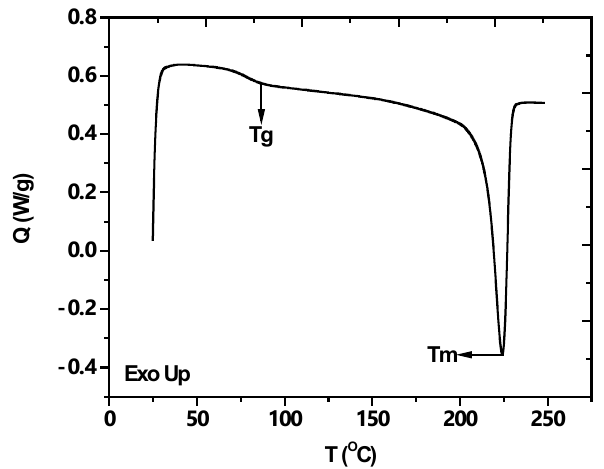
Figure 13. DSC thermograph of the DPSF/PVA